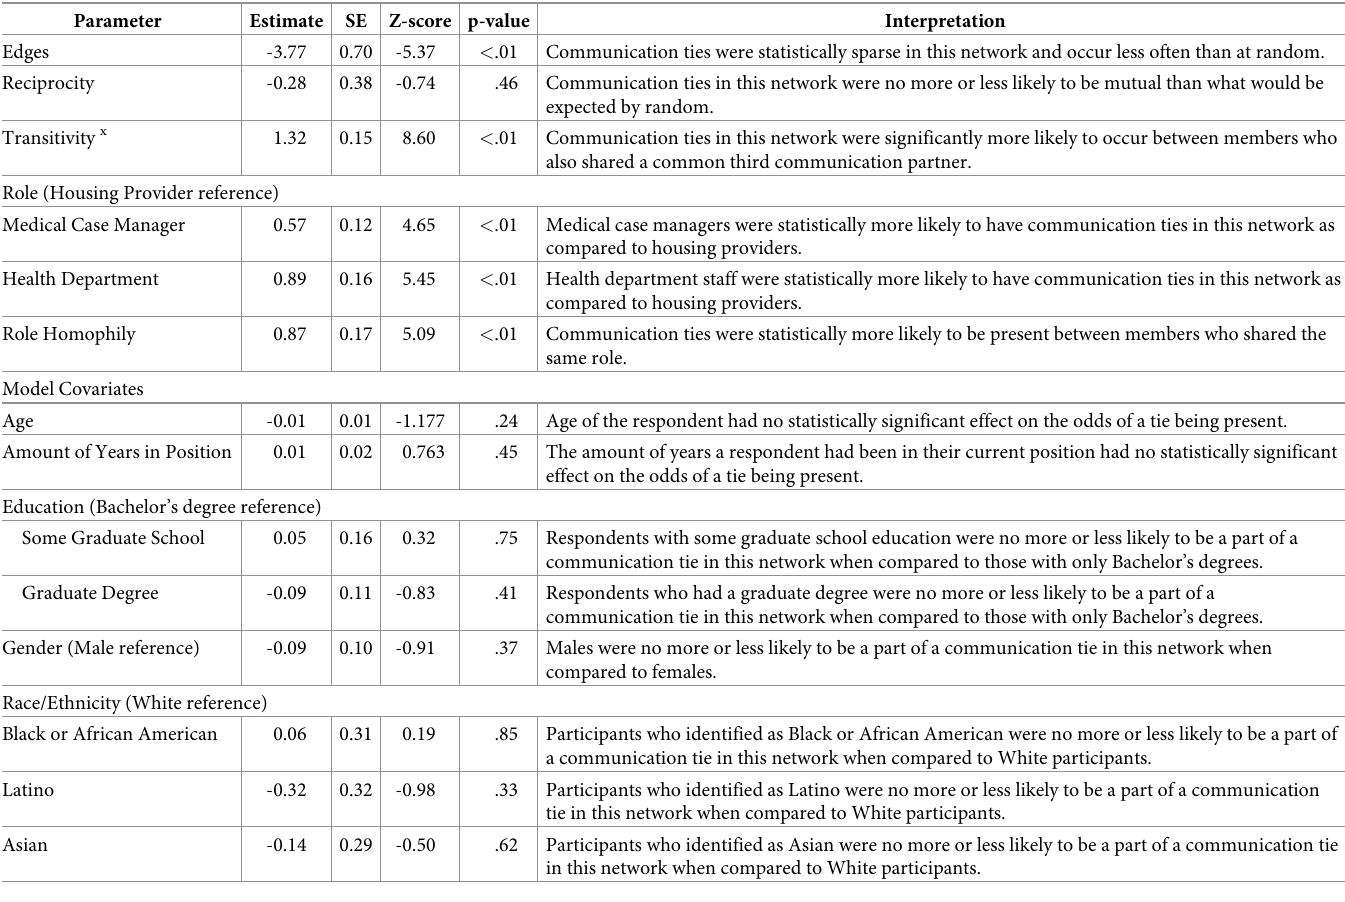
Table 3. Model parameter estimates and standard errors for collaborative ties within the Ryan White